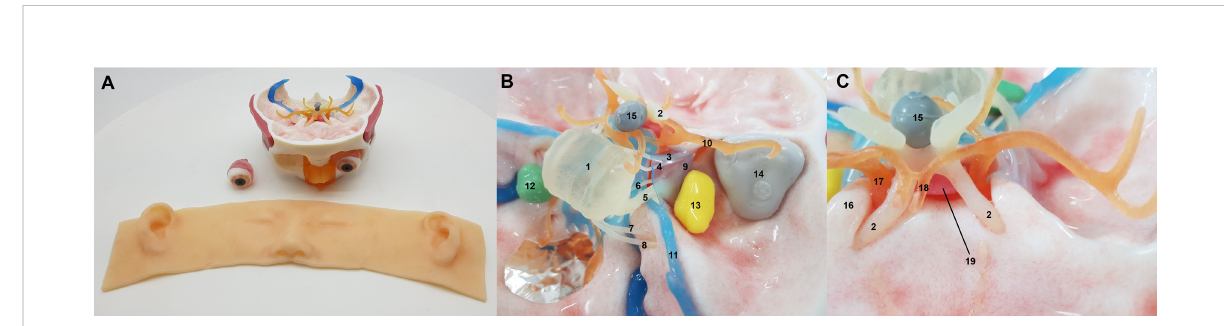
FIGURE 1 The three-dimensional printed simulation model. External view (A) and reconstructed neurovascular structures and lesions (B, C) . Key: 1, pons; 2, optic nerve; 3, oculomotor nerve; 4, trochlear nerve; 5, trigeminal nerve; 6, abducens nerve, 7, facial nerve; 8, vestibulocochlear nerve; 9, lateral wall of cavernous sinus; 10, middle cerebral artery; 11, superior petrosal sinus; 12, vestibular schwannoma lesion; 13, trigeminal schwannoma lesion; 14, spheno-orbital meningioma lesion; 15, craniopharyngioma lesion; 16, anterior clinoid process; 17, internal carotid artery; 18, anterior cerebral artery; 19, pituitary